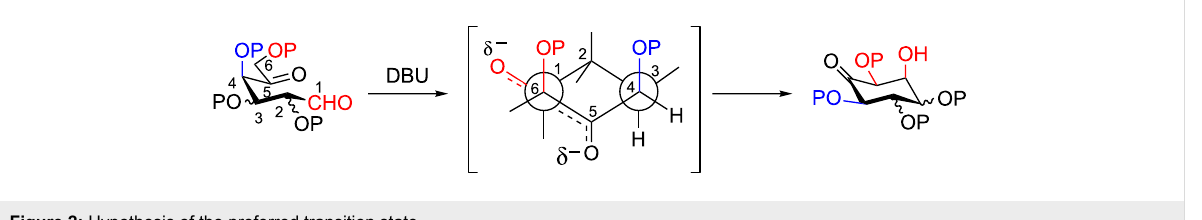
Figure 2: Hypothesis of the preferred transition